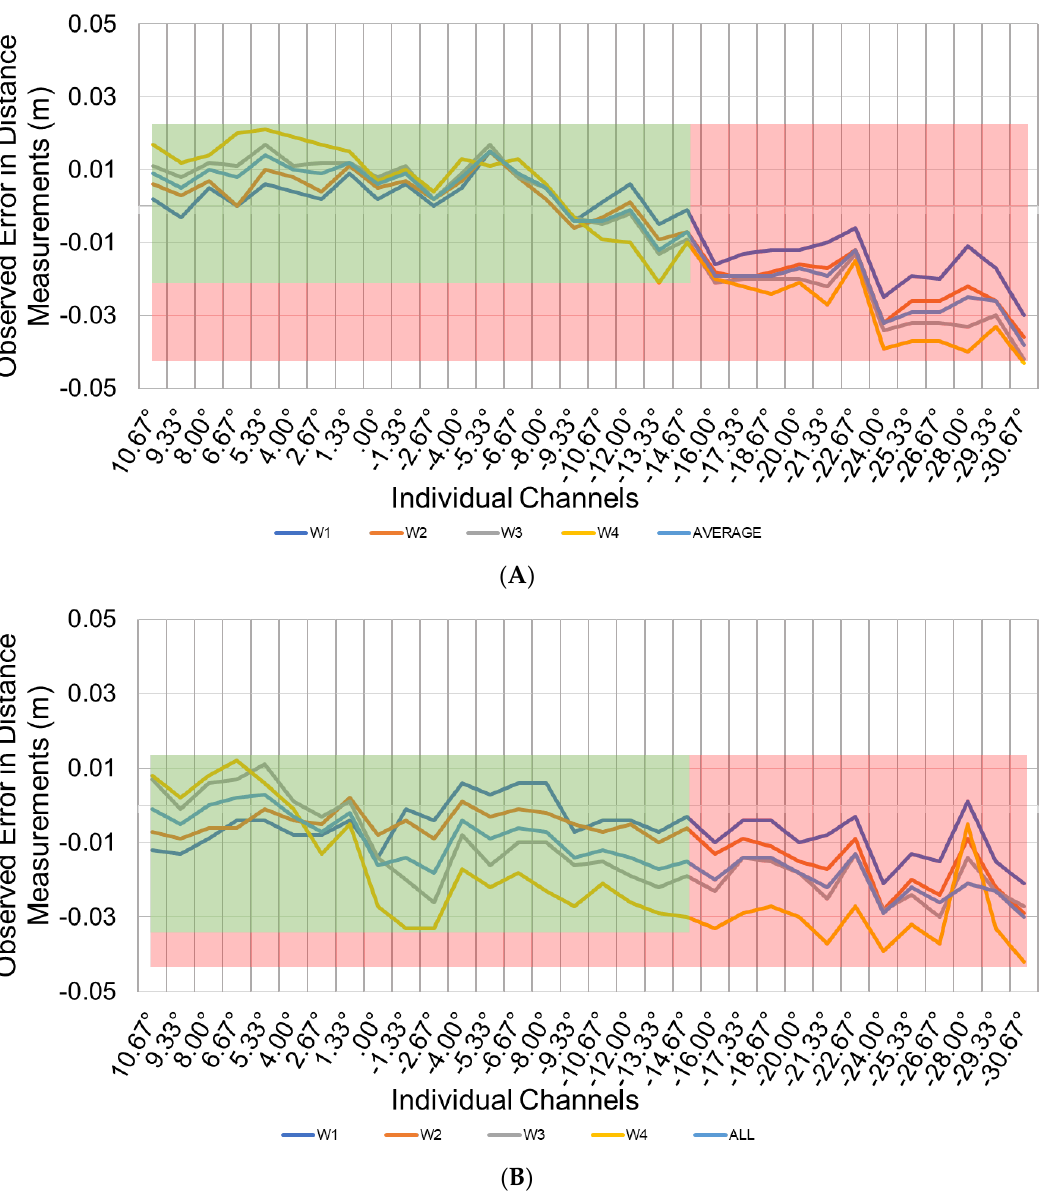
Figure 21. Calculated error (m) per individual channel, per subsections of target surface in Velodyne ® HDL–32E during a 30 m ( A ) night experiment and a ( B ) day experiment. The green box highlights the reduced error observed when individual channels with offset angles greater than 15° are removed from the results, with the red box encompassing the total observed error by all individual scanners.